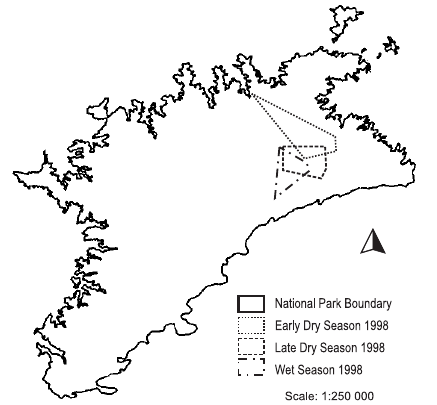
Fig. 6. Map of MNP indicating seasonal ranges of a female wild rhino number 7.